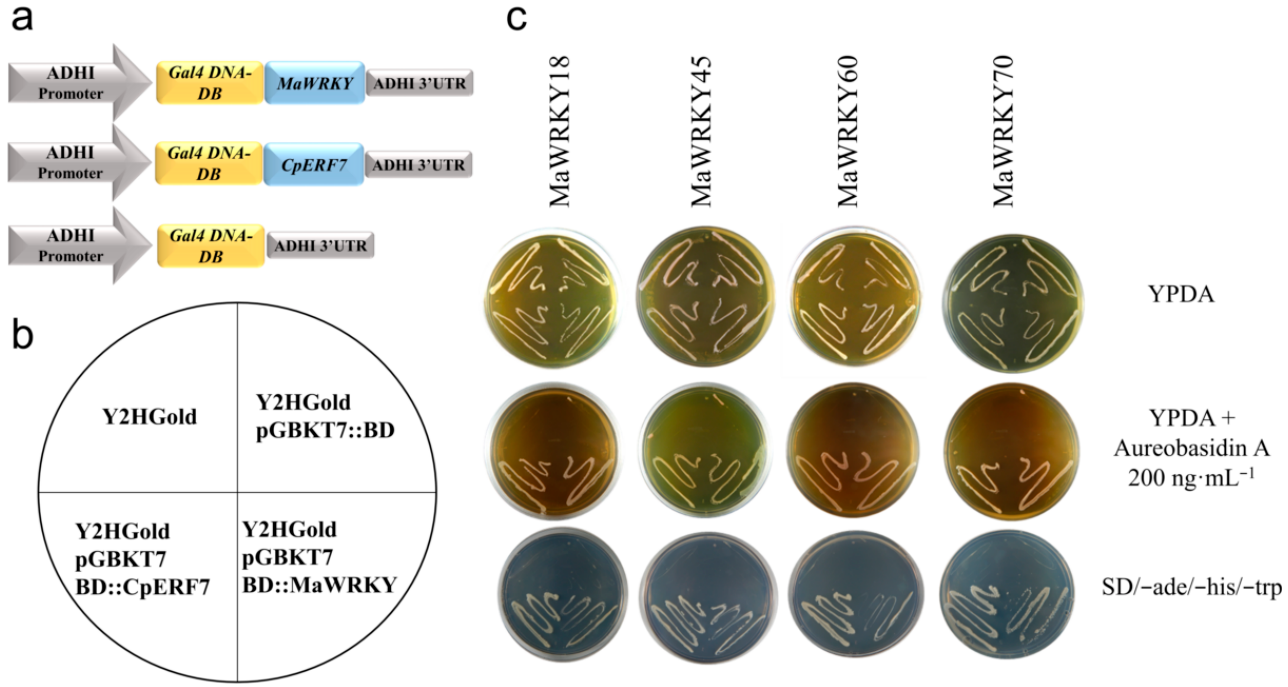
Figure 7. Transactivation activity analysis of MaWRKY18, MaWRKY45, MaWRKY60, and MaWRKY70 in Y2HGold yeast. ( a ) Schematic representation of the expression cassettes used for the transient expression analyses. Gene expression is regulated by the ADH1 promoter and terminator present in the pGBKT7 vector. ( b ) The diagram shows the order in which the yeast strains were plated. ( c ) Yeast strains transformed with MaWRKYs fused with Gal4 DNA-BD were grown in YPDA or YPDA supplemented with aureobasidin A or SD minimal medium (-Trp, -His, -Ade). The Gal4 DNA BD:: CpERF7 construct [41] was used as a positive control in this